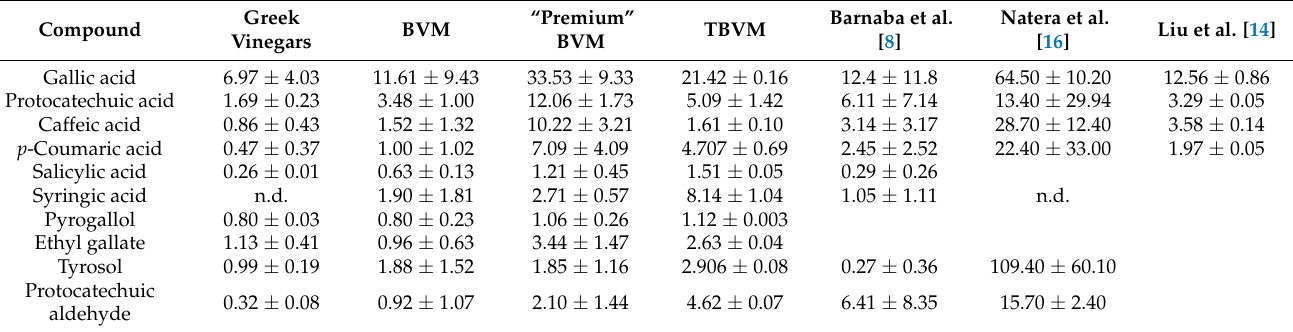
Table 2. Comparison of the content (mean; standard deviation; mg/L) of the major phenolic com- pounds from different studies. Our results are presented for each type of balsamic vinegar separately. Greek vinegars ( n = 3; sample No. 1 was not included because a lack or different content of these compounds), BVM ( n = 4), “premium” BVM ( n = 5), TBVM ( n = 1), [8] ( n = 8), [16] ( n = 6), [14] ( n = 1). Average values from current study are calculated for samples containing the compounds in higher levels than limits of quantification (according to Table